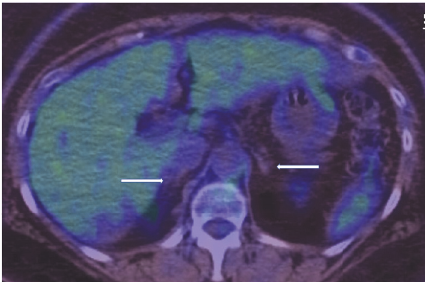
Figure 4: At the end of treatment. Posttreatment PET-CT scan showing normal sized adrenal glands (white arrows) with no significant FDG activity.